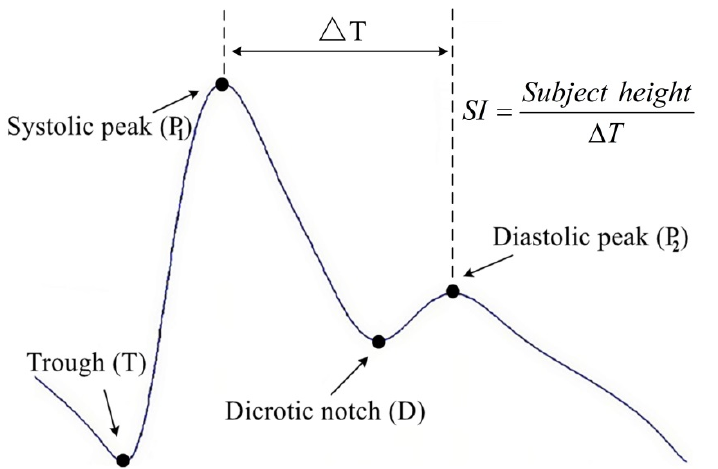
Figure 1. Measurement of digital volume pulse (DVP) by transmission of infrared rays through the finger. Generally, DVP comprises a systolic peak (the first peak) and a diastolic peak (the second peak). Δ T = the time difference between the first and second peak; stiffness index (SI) = body height/ Δ T.